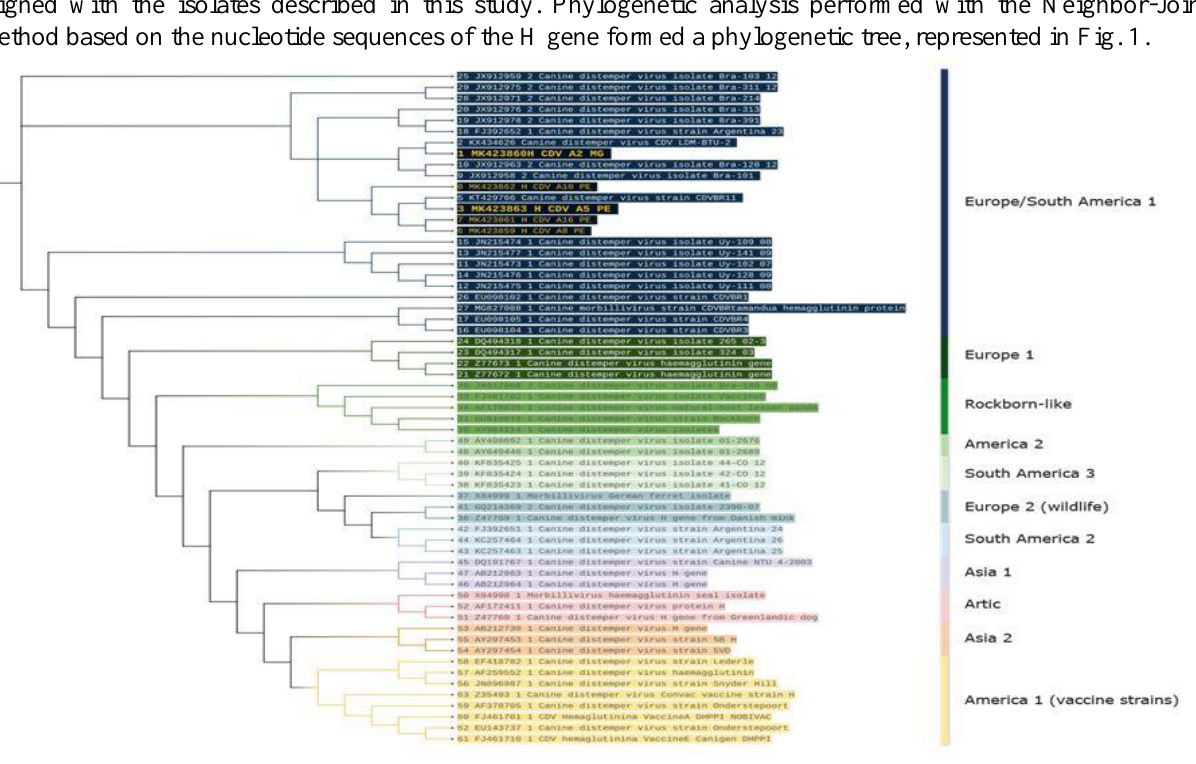
Fig.1: Phylogenetic relationship among CDV strains selected in Genbank (sequence identifications used in Tab. 3), based on the Hemagglutinin protein